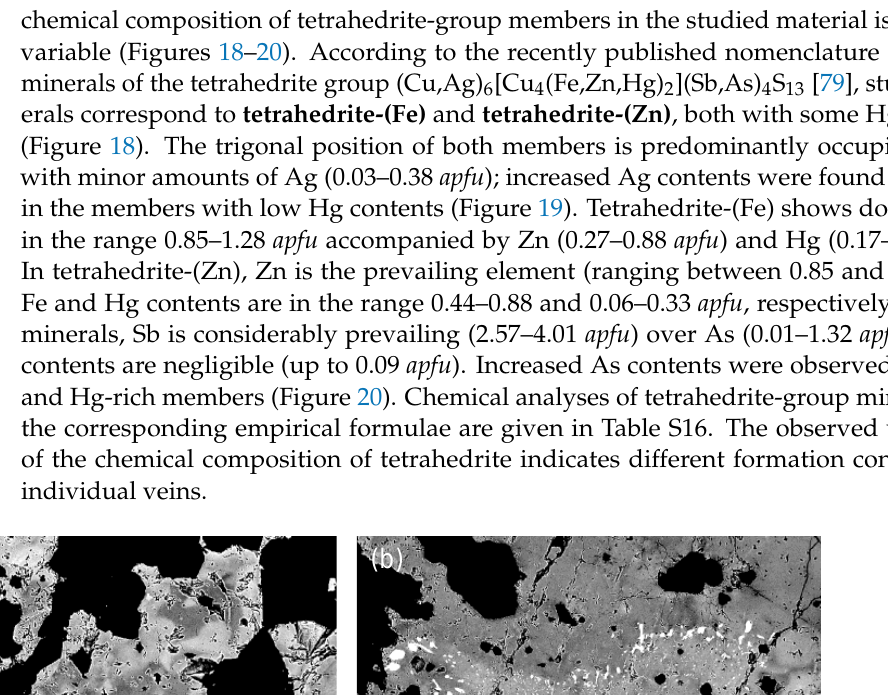
Figure 17. ( a ) Zonality of tetrahedrite-(Fe) due to HgFe -1 and SbAs -1 substitutions; ( b ) bismuthinite inclusions (white) in zonal tetrahedrite-(Fe). BSE photos.